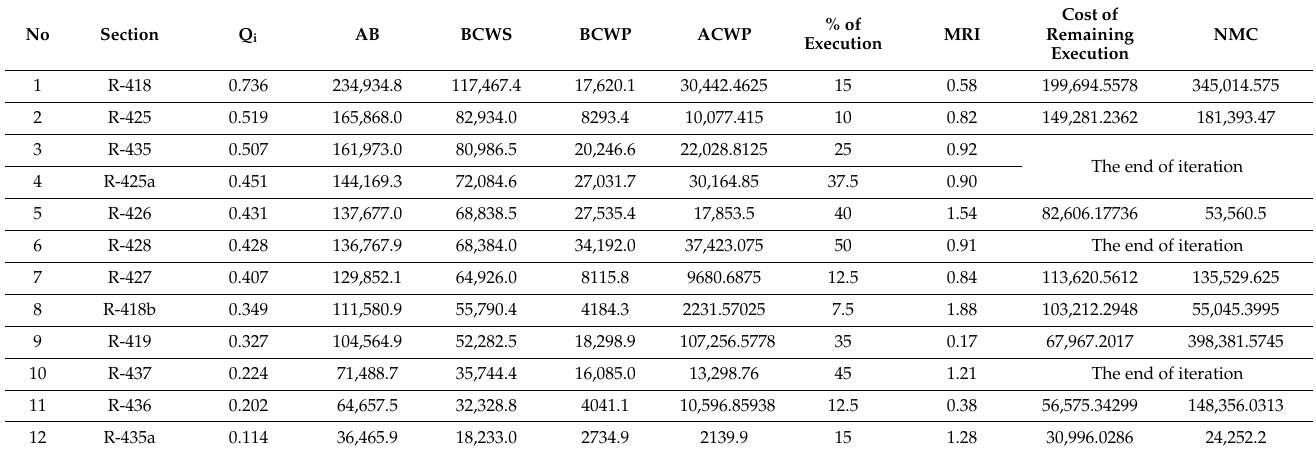
Table 8. Results of monitoring and control process—Iteration 1.